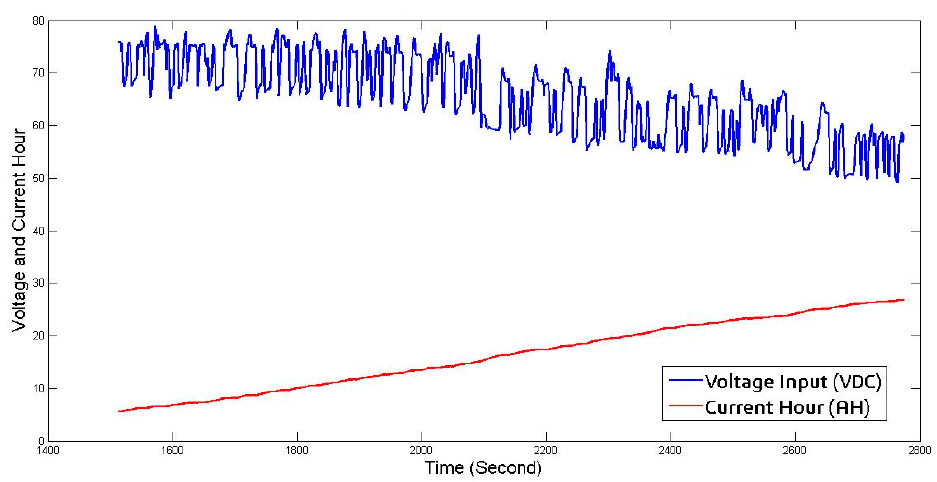
Figure 12. Discharge vs. AH accumulation.